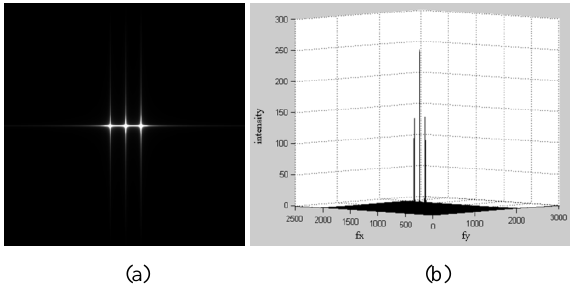
Figure 4. Fourier spectrogram. (a)Top view. (b)3-D view. Select a suitable rectangular filter as shown in Figure 5, do inverse Fourier transform, and calculate the degree of the linear polarization (DoLP) as 0.86. Compared with the DoLP of the original incident light, the reconstruction error is 13.5%.